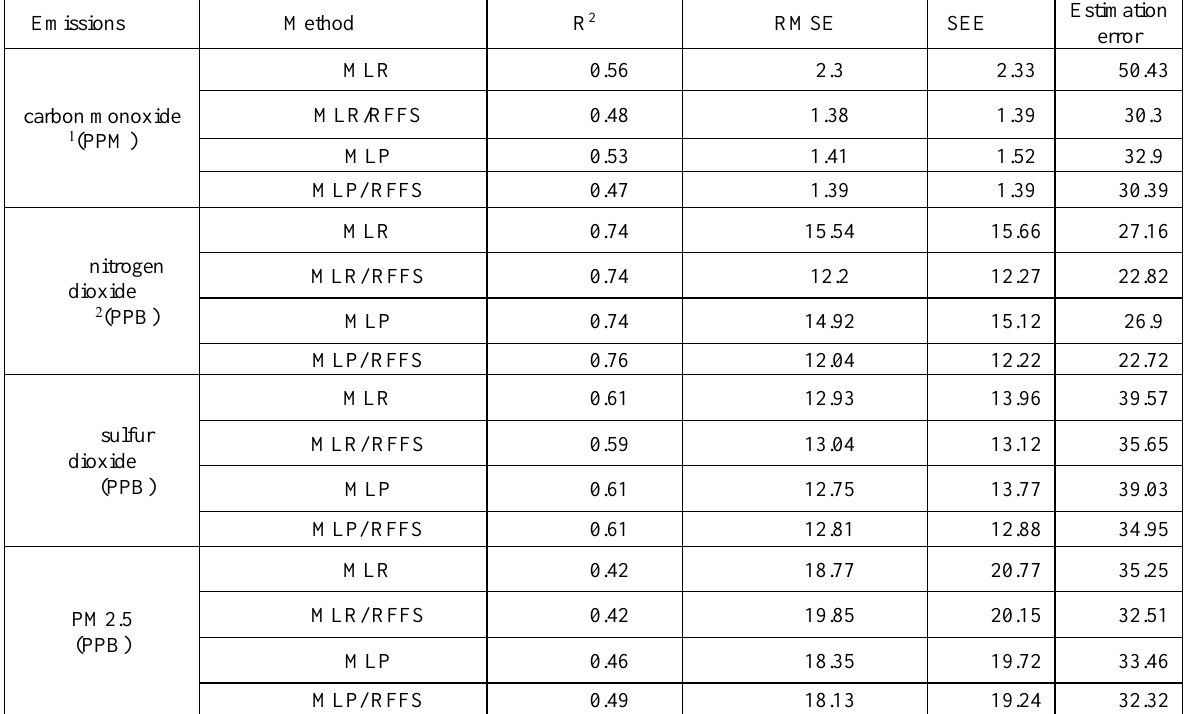
Table 1. Results of MLR and MLP applied on test data